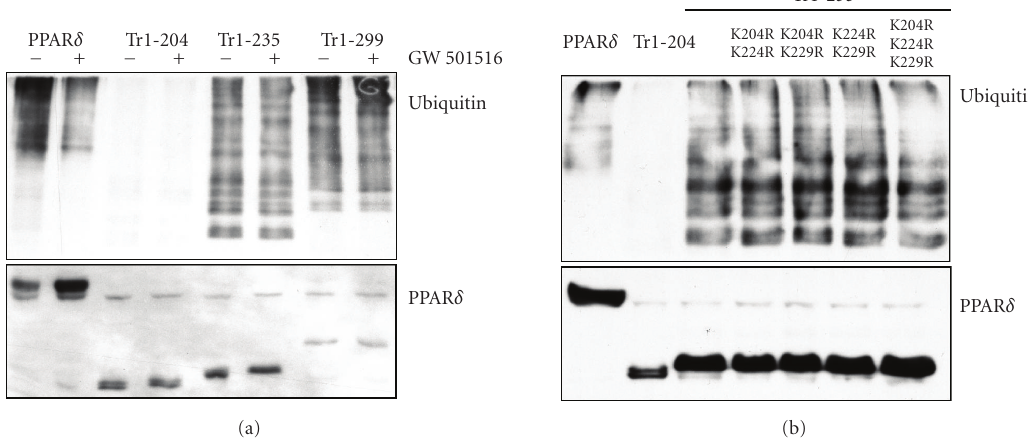
Figure 2: Ubiquitination of truncated and mutated forms of PPAR δ . (a) U2OS cells were transfected with HA-ubiquitin expressing vector along with wild type His-PPAR δ or truncated forms of the receptor (PPAR δ /Tr1-204, Tr1-235 and Tr1-299). After 24 hours, cells were incubated overnight with vehicle or the PPAR δ ligand GW501516 (5 μ M) and subsequently all samples were incubated with 10 μ M the proteasome inhibitor PS341 for 4 hours. His-tagged wild type and truncated PPAR δ were pulled-down with nickel a ffi nity gel under denaturing conditions. PPAR δ was detected in pull-down fractions using an anti-His antibody and ubiquitinated proteins with an anti- HA antibody. (b) U2OS cells were transfected with HA-ubiquitin vector along with the indicated PPAR δ expressing vectors. PPAR δ /Tr1-235 had wild type sequence or the indicated double or triple mutations (K204R, K224R and K229R). Cells were treated and analyzed as